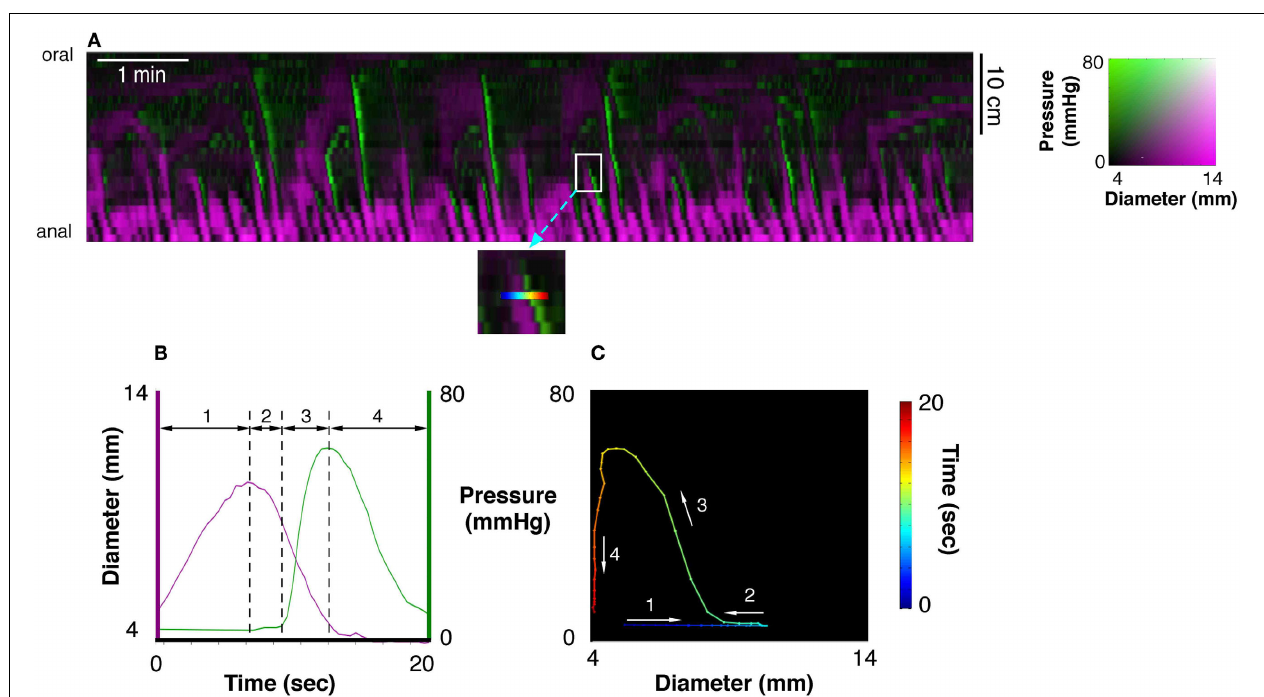
FIGURE 2 | (A) A 10min spatiotemporal diameter/pressure map (DPMap) recorded over a 25cm long piece of rabbit colon during a basal period in one rabbit. Intraluminal pressure is shown as black (low pressure) to green (high pressure) and the changes in diameter are similarly shown in shades of magenta. The white box in (A) , is shown expanded (inset below the DPMap) and a rainbow colored line in it marks 20s at one site used for subsequent analysis. The line plots, of pressure (green) and diameter (magenta) from the inset are plotted against time in (B) , and against each other in the orbit plot (C) . The rainbow-colored line in the inset (from blue via green, yellow to red)